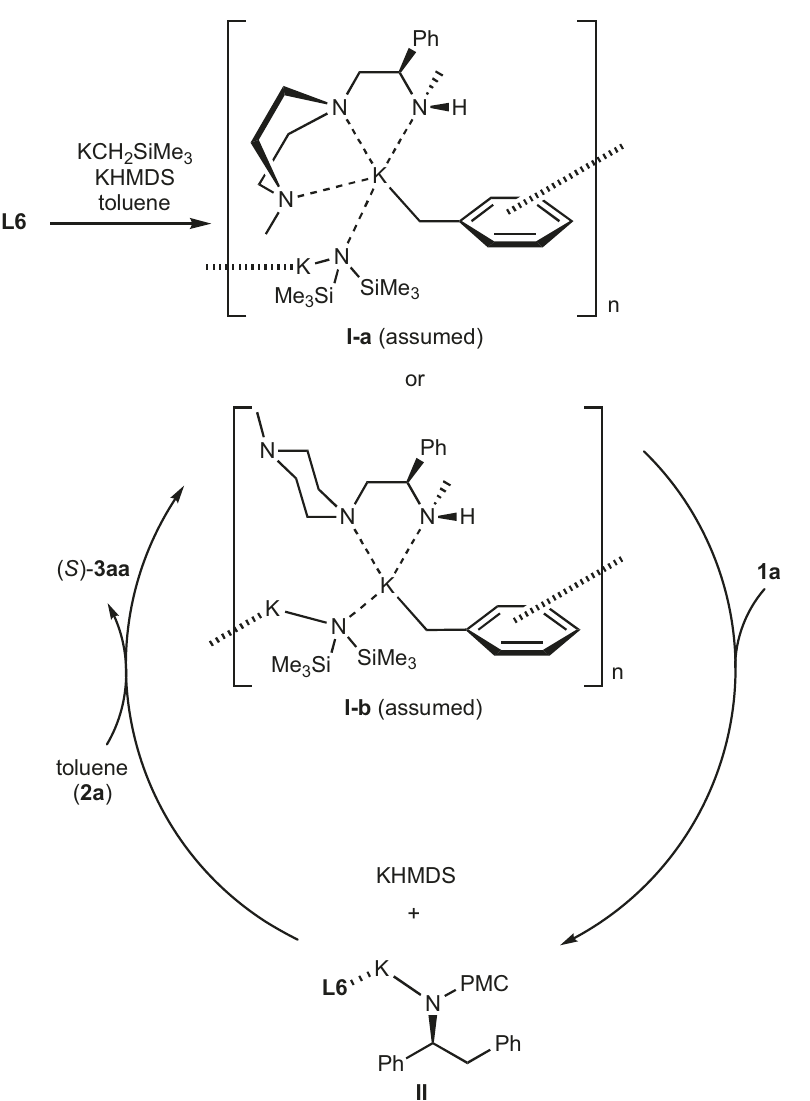
Fig. 3 Proposed mechanism. Fist, oligomeric complex composed of benzyl anion, the chiral ligand, and KHMDS is formed. Then, nucleophilic addition which affords a strongly basic reaction intermediate undergoes after deaggregation. The intermediate deprotonates the next toluene to afford the desired adduct and regenerate the original oligomeric